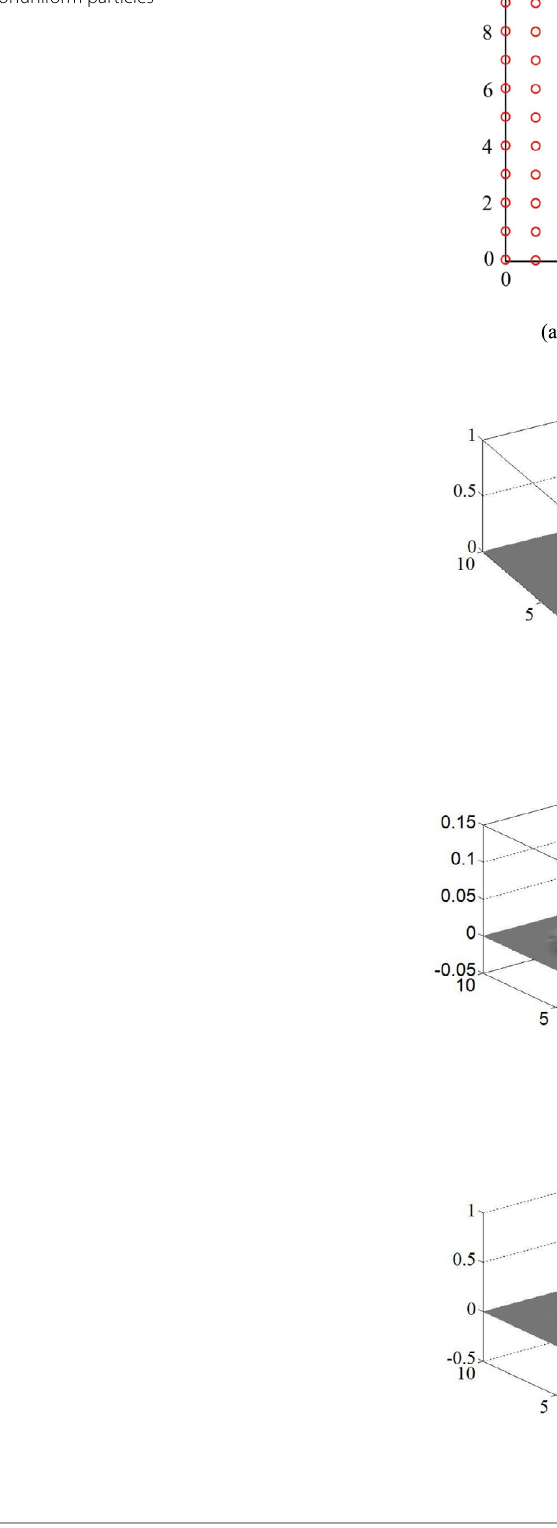
Figure 1 Shape functions of 2D IRKPM with nonuniform